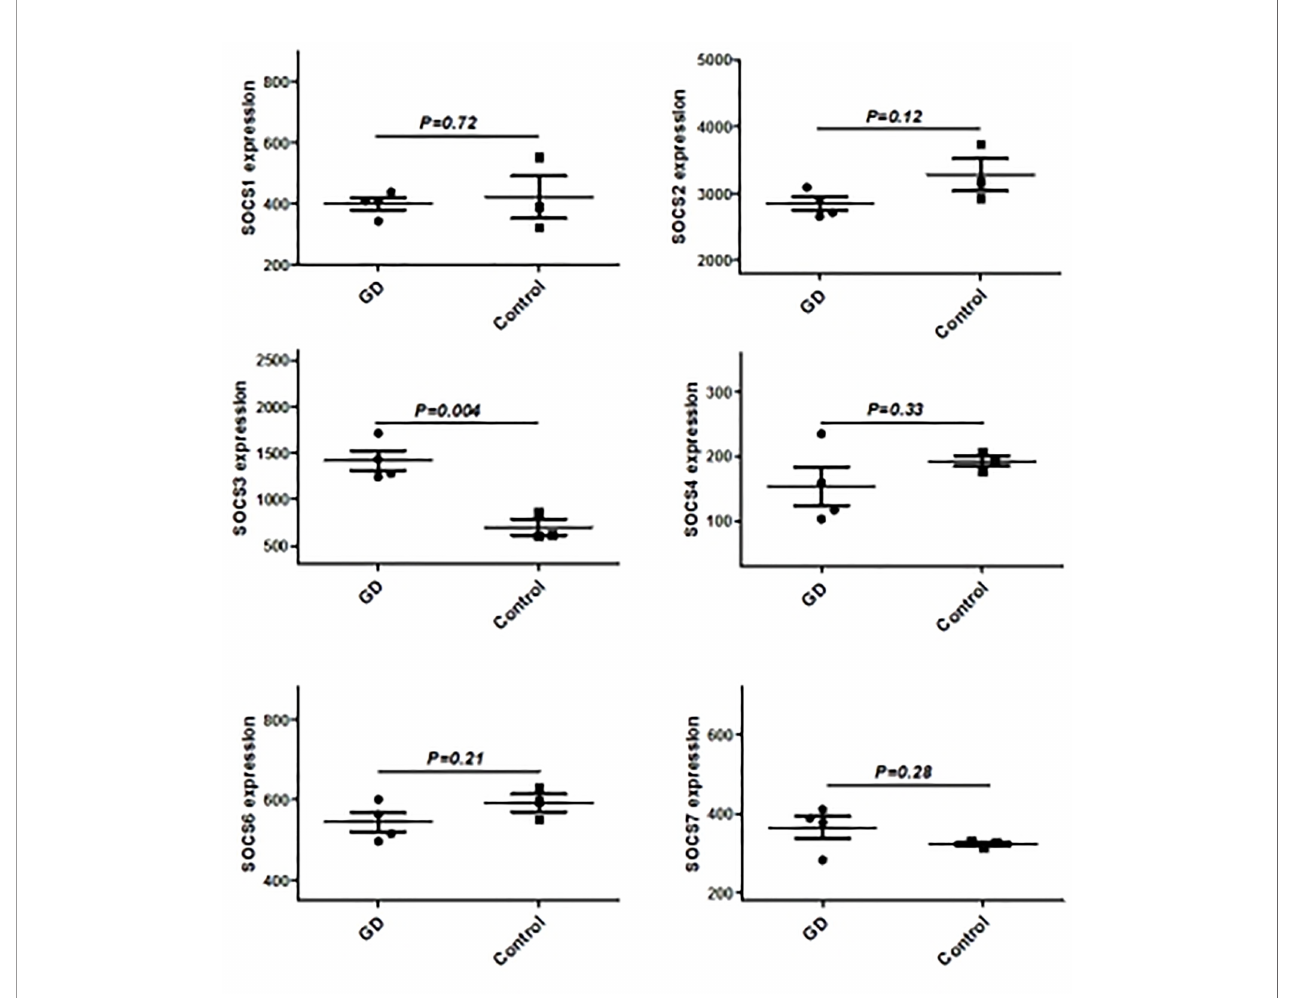
FIGURE 2 | The mRNA expression of SOCS family main members in in thyroid from GD and